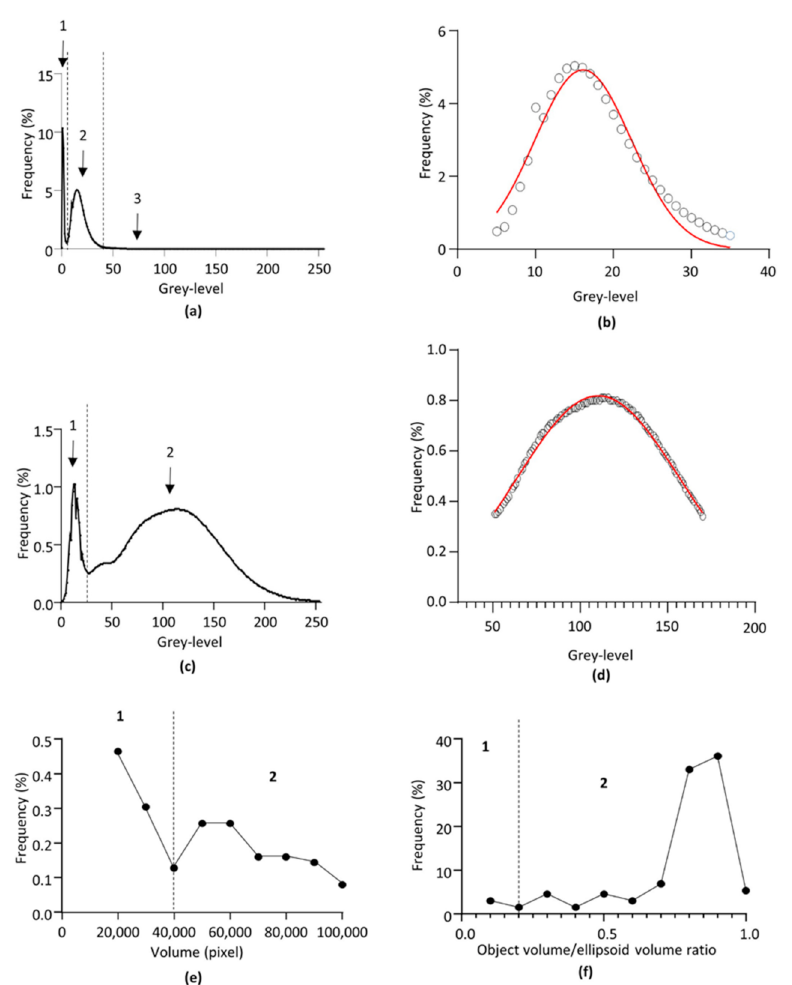
Figure 1. Thresholding process. ( a ) Representative frequency distribution curve of the voxel greyscale value from one lectin-labelled kidney after 3D imaging and 8-bit format conversion. Greyscale values range from the darkest (0) to the brightest (255) voxels of the image. 1: background. 2: non-labelled renal structures. 3: lectin-labelled structure. ( b ) Gaussian fit of the subset of pixels corresponding to the renal tissue from curve ( a , c ). Representative frequency distribution curve of the voxel greyscale value from one non-lectin-labelled kidney after 3D imaging and 8-bit format conversion. Greyscale values range from the darkest (0) to the brightest (255) voxels of the image. 1: background. 2: non-labelled renal structures. ( d ) Gaussian fit of the subset of pixels corresponding to the renal tissue from curve ( c , e ). Representative frequency distribution curve of the selected objects after greyscale segmentation. Black dots are the center of each frequency class. Vertical dotted line indicates the inflexion point chosen as volume threshold. 1: excluded small lectin-labelled objects. 2: selected big lectin-labelled objects. ( f ) Representative frequency distribution curve of the ratio between the real objects volume and the theoretical ellipsoid volume of the objects selected after volume-based segmentation. Black dots are the center of each frequency class. Vertical dotted line indicates the inflexion point chosen as the shape-based threshold. 1: excluded non-ellipsoid shaped objects. 2: selected ellipsoid shaped